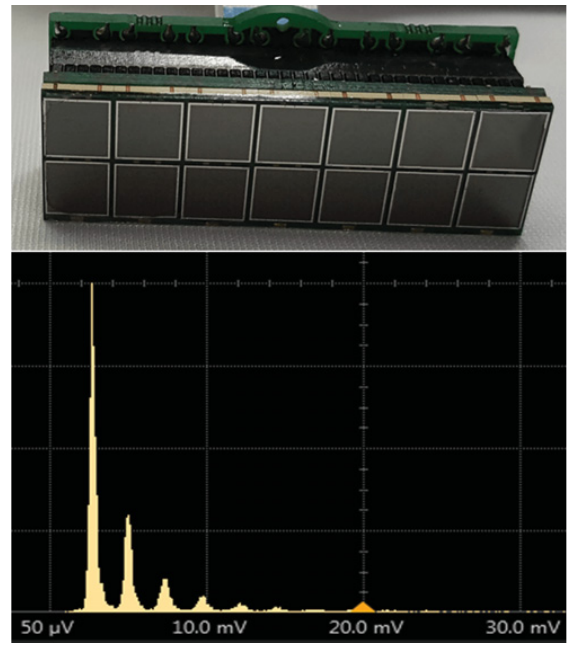
Figure 3. MPPC array. Upper panel: MPPC composed of the single SiPM sensors (its total size is about 15 × 45 mm). Bottom panel: Scope screen-shot of the dark count spectrum of the oscillating Hamamatsu SiPM read out by custom made